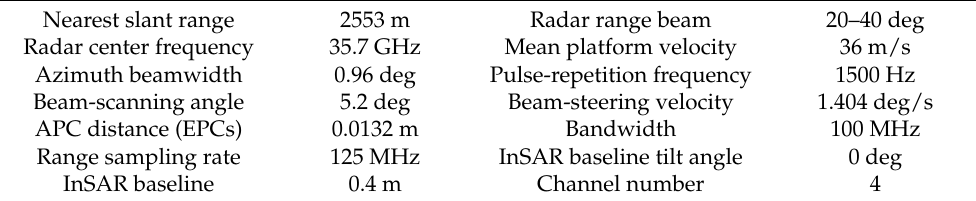
Table 3. Parameters of airborne DBF-TOPS SAR in